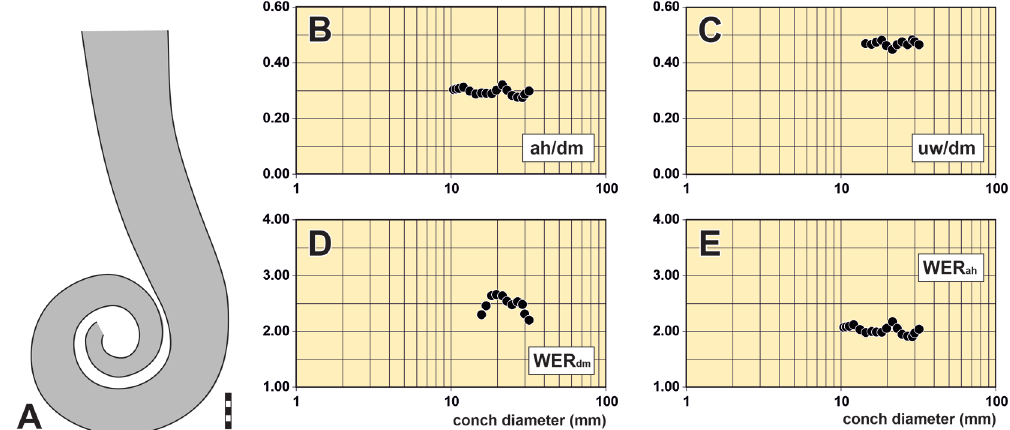
Fig. 56. Lituites bottkei sp. nov. A . Outline of coiled conch part of holotype MB.C.29651. B–E . Conch proportions and coiling rates of holotype MB.C.29651. Scale bar units = 1 mm.